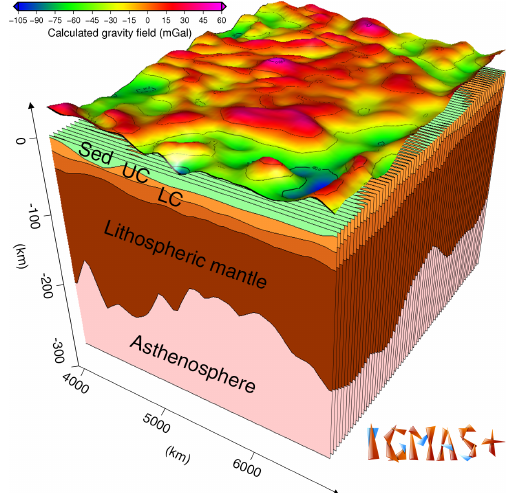
Figure 8. A 3D lithospheric model of Volgo–Uralia developed in IGMAS + software. It consists of 67 vertical sections which gives a spatial resolution of approximately 50km. The model includes 5 main layers: sediments (Sed), upper crust (UC), lower crust (LC), lithospheric mantle, asthenosphere, and an additional 6th layer of underplating. The Bouguer gravity anomaly produced by the model is shown on